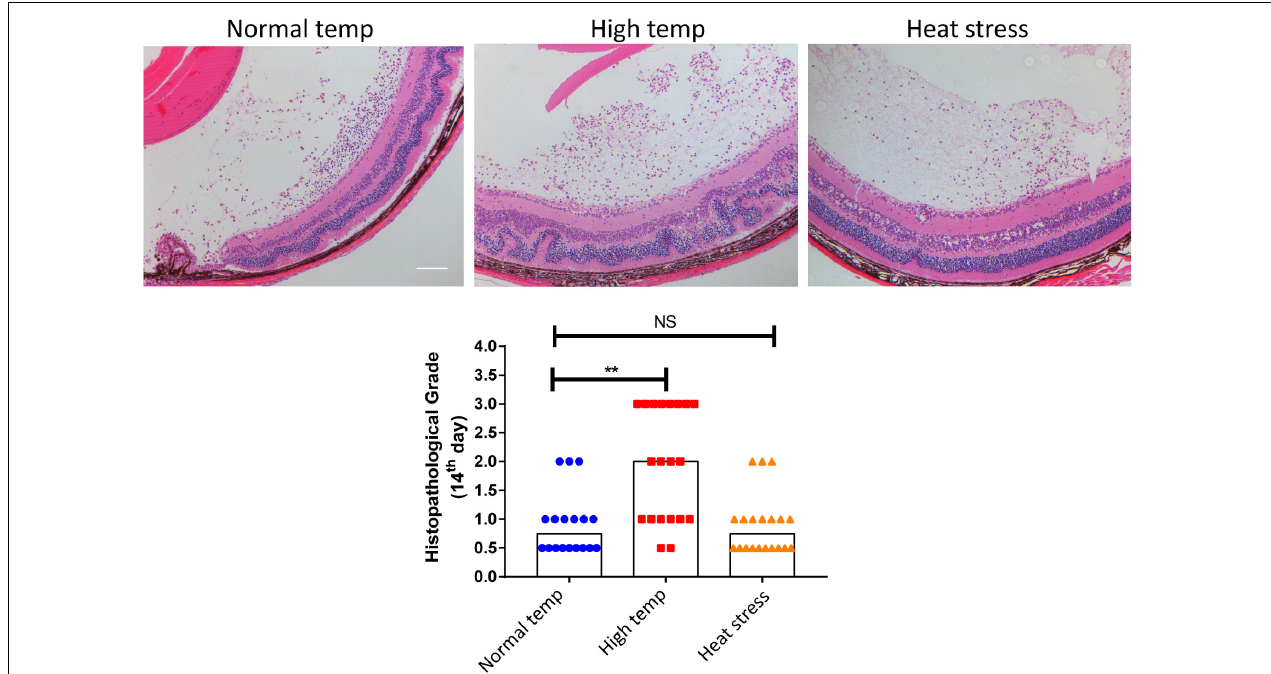
FIGURE 1 | A high temperature environment aggravates ocular inflammation in EAU mice. Left, representative hematoxylin and eosin images of eye sections from EAU mice (day 14 after IRBP immunization) kept at normal temperature, high temperature or a so-called heat stress environment. Scale bar, 10 µ m. Quantification of the histopathological score. Representative data from 3 independent experiments ( n normal temp = 18, n high temp = 20, n heat stess = 20; median; ** p < 0.01; NS, no statistical differences; differences were assessed by the Kruskal–Wallis